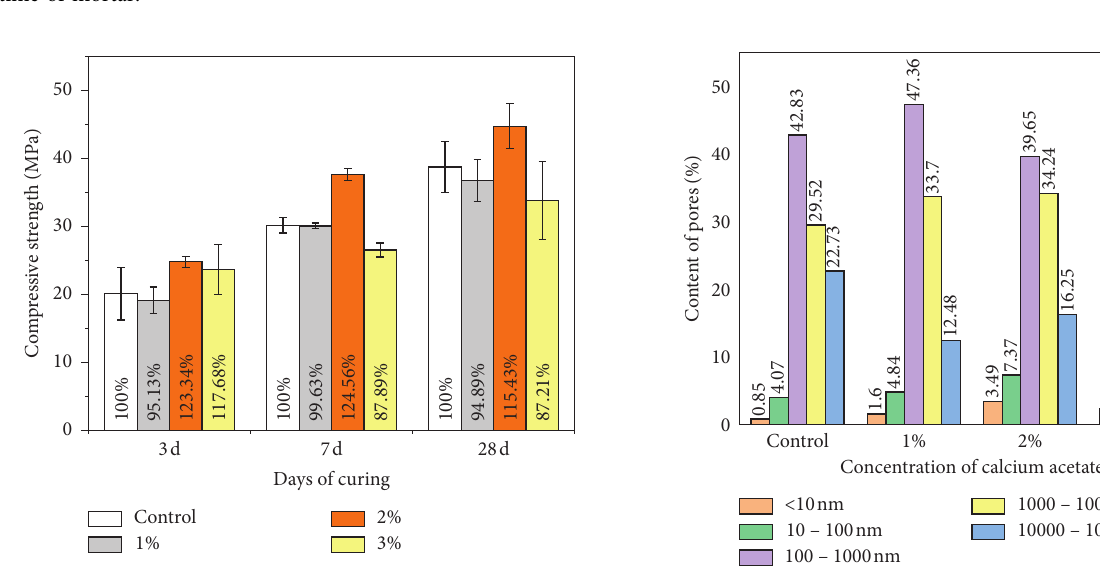
Figure 6: Effect of calcium acetate concentration on the setting time of mortar.